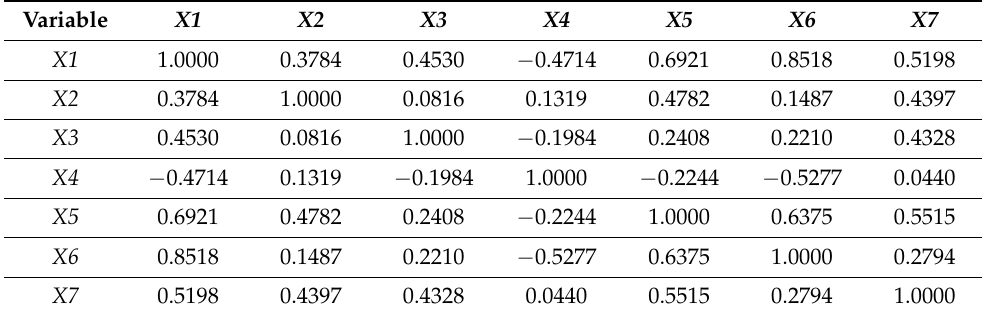
Table 2. Correlation matrix between variables.